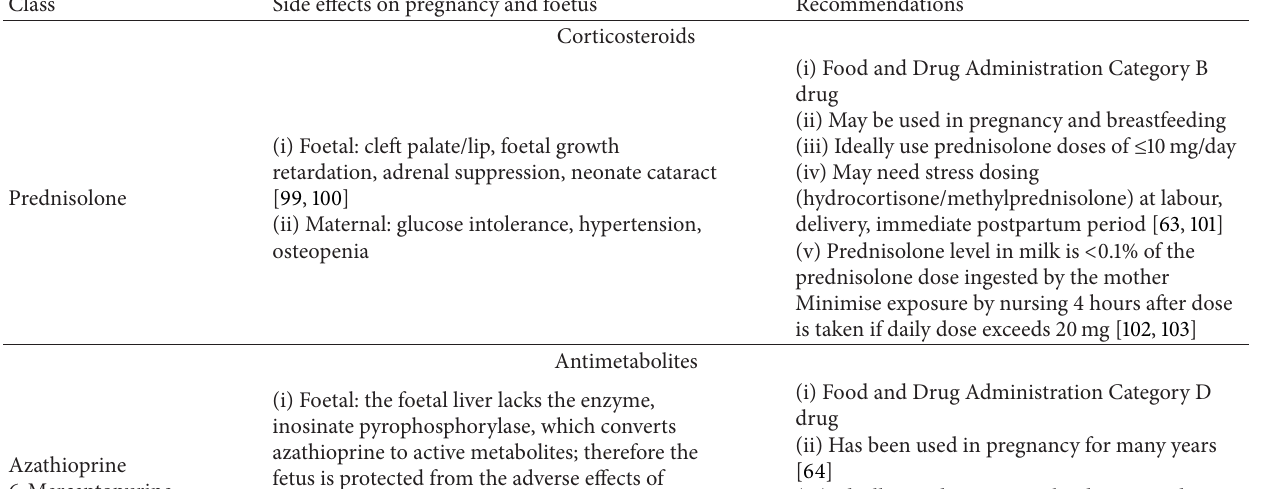
Table 1: Immunosuppressive drugs in pregnancy and lactation (adapted from reviews on immunomodulatory agents in pregnancy) [59, 62–